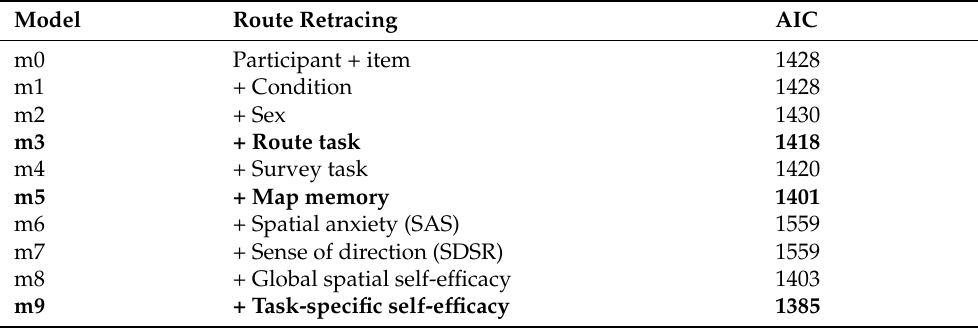
Table 2. Route retracing: stepwise model selection results. Variables that decreased AIC appear in